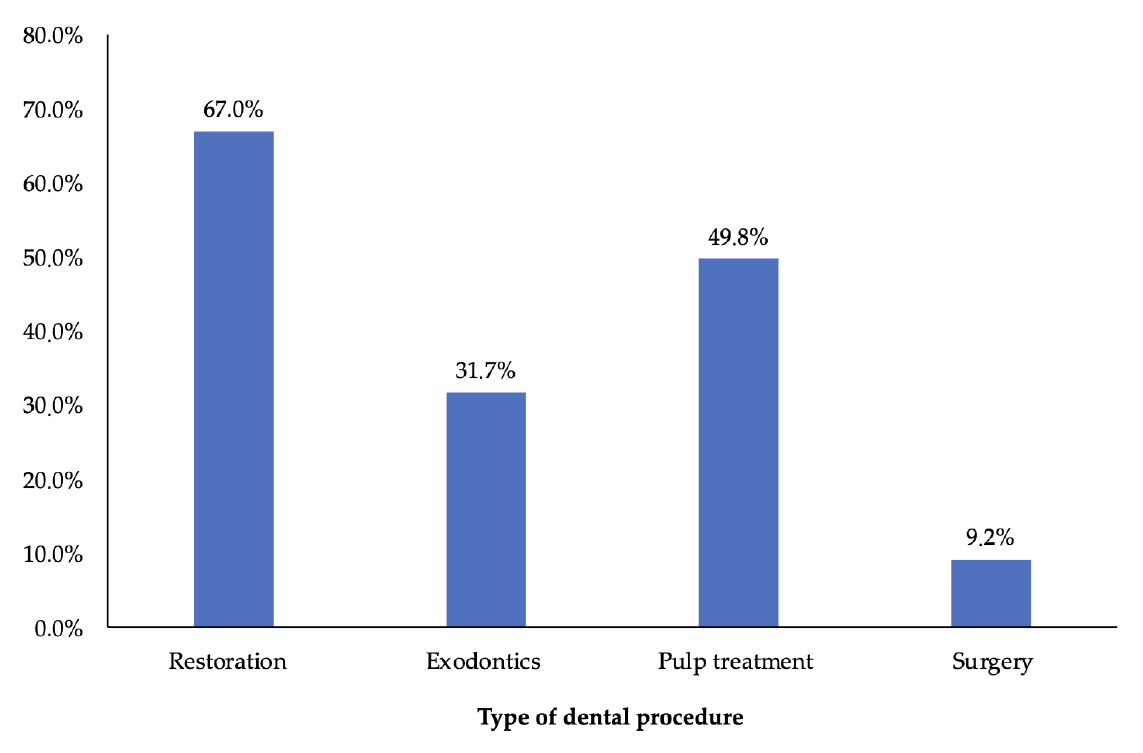
Figure 1. Type of dental procedure. Note: The most frequently performed procedures were restora-